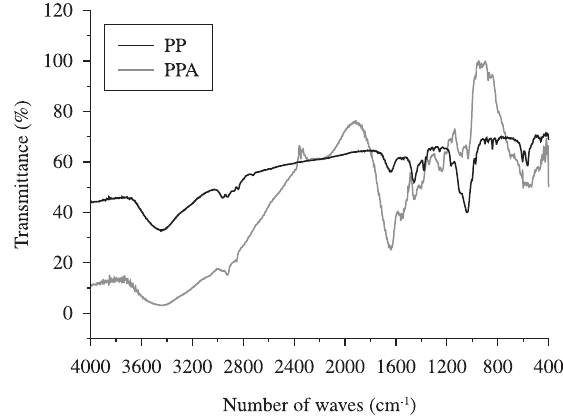
Figure 1. FTIR spectrum of polypropylene (PP) and polypropylene/açaí fiber composite